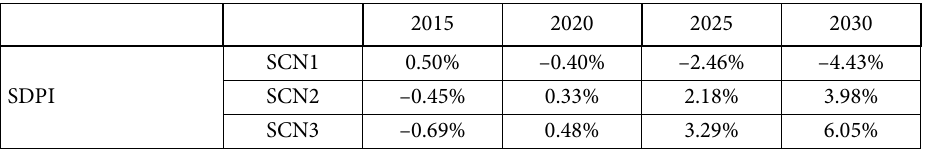
Table 3. Changes in the SDPI in policy scenarios (% change relative to the